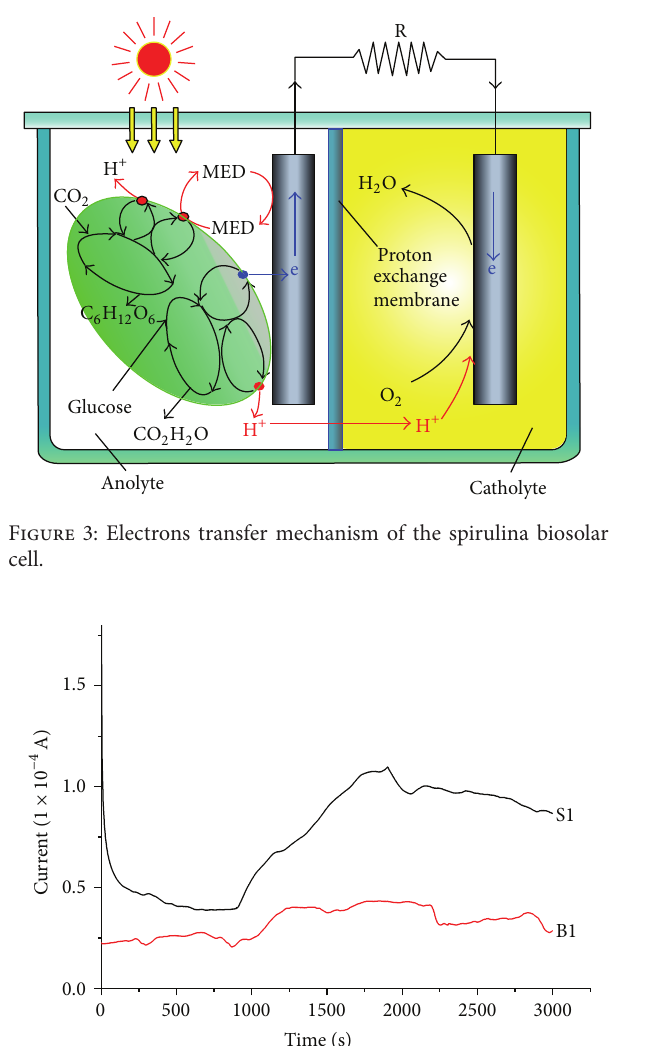
Figure 6: Current-time curves of the solar cell with sucrose in the anode chamber under the light and dark for three times. With spirulina, S3: the first time, S4: the second time, S5: the third time; B2: without